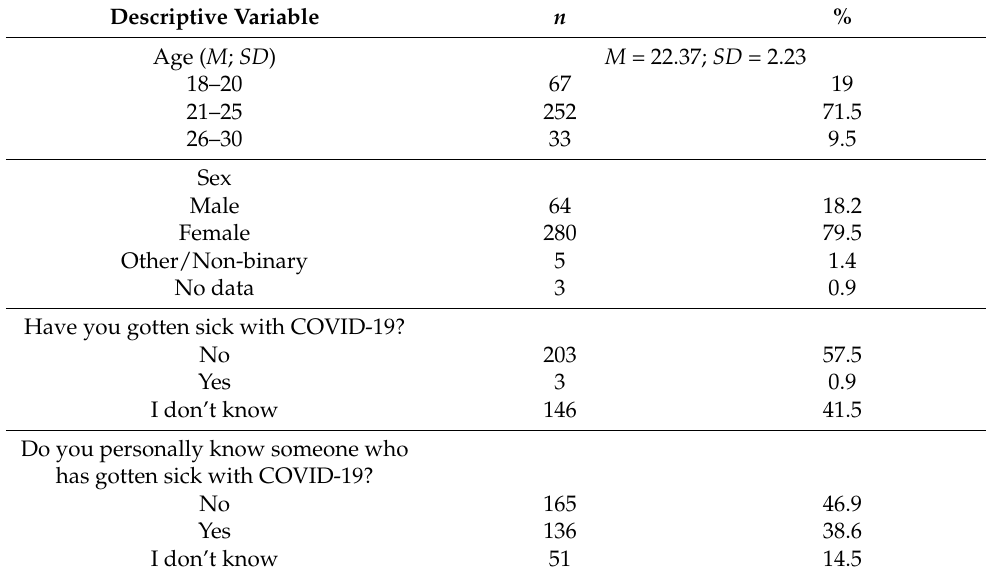
Table 1. Participants’ demographic data (Study